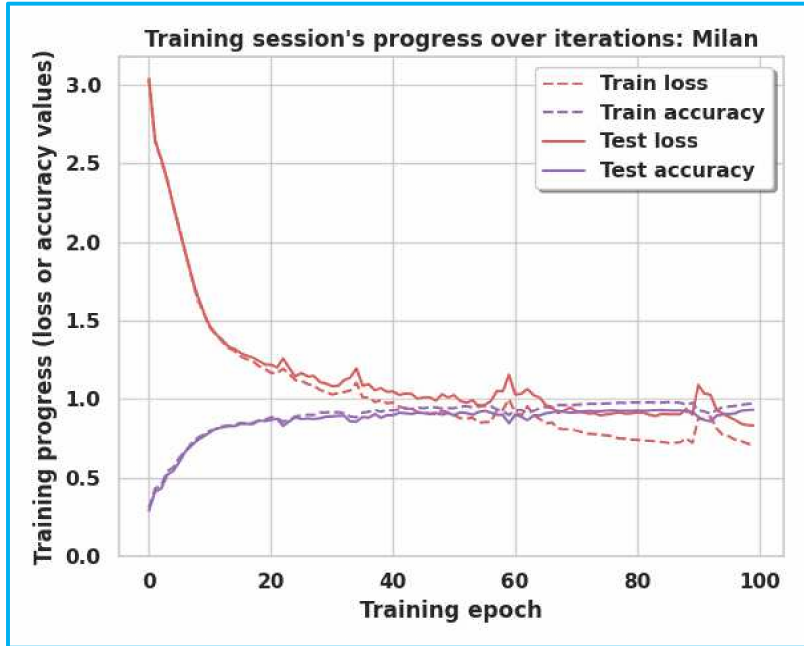
Figure 5. Training/Test Accuracy/Loss for Milan.